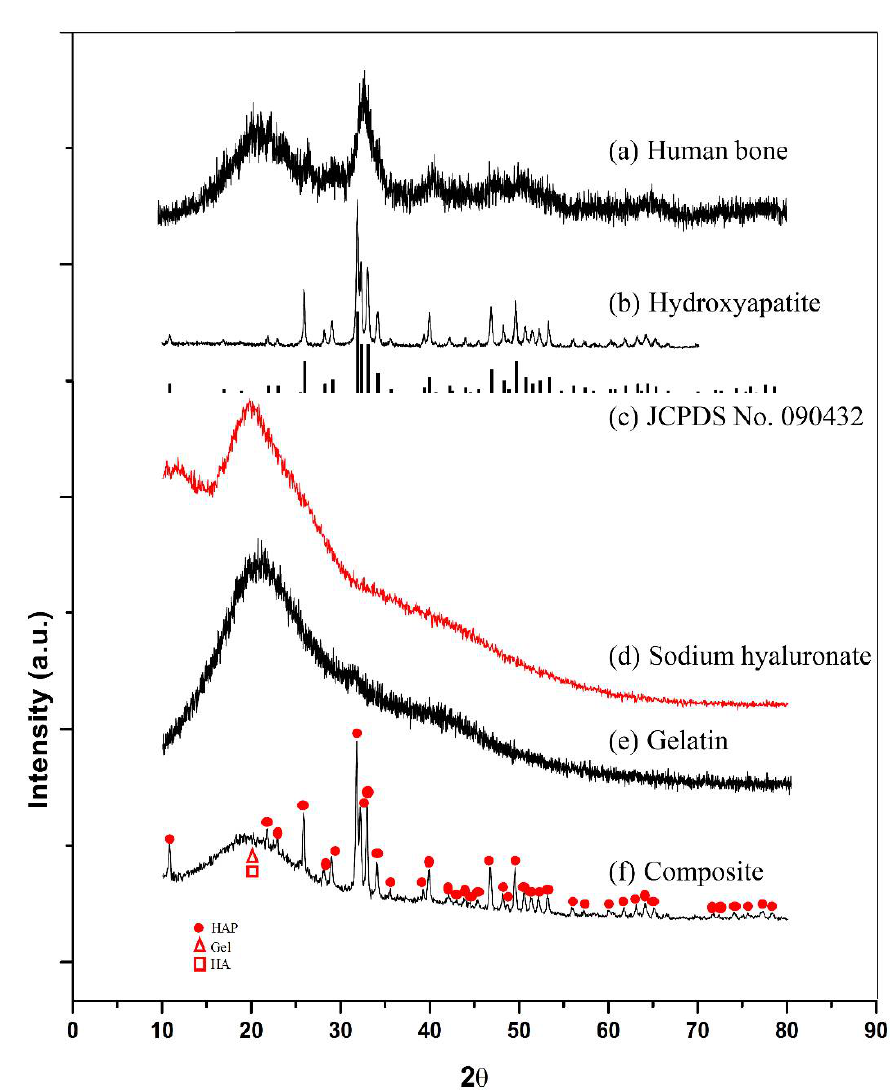
Figure 2. XRD analysis. ( a ) Human bone, ( b ) hydroxyapatite, ( c ) JCPDS No. 090432, ( d ) sodium hyaluronate, ( e ) gelatin, and ( f ) Gel/HA–HAP composite. The red dots, triangle and rectangle indicate the characteristic peaks of hydroxyapetites, gelatin and sodium hyaluronate, respectively. The Gel/HA–HAP composite prepared in this study had a similar composition to human bone.